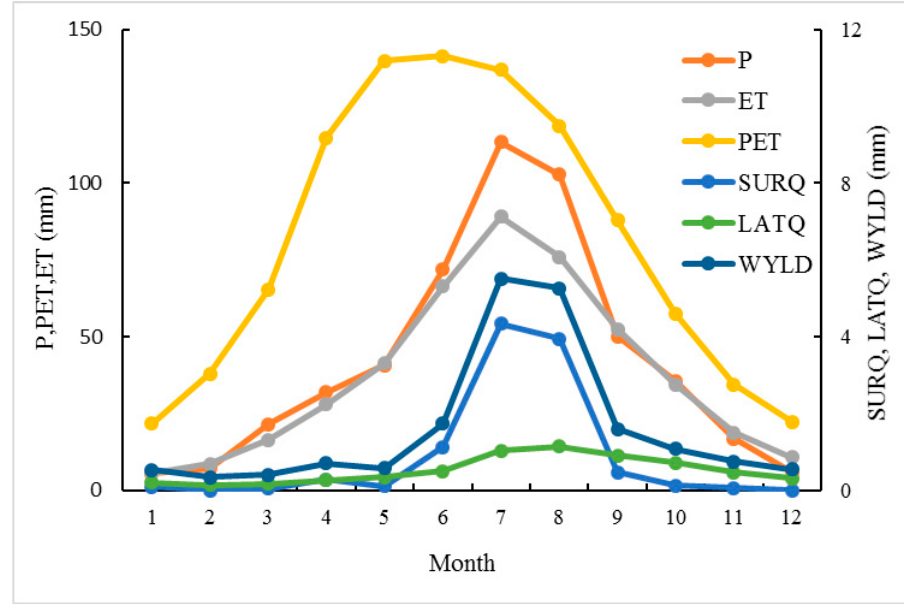
Figure 6. Monthly mean water balance components from 1986 to 1999. (P: precipitation, ET: actual evapotranspiration, PET: potential evapotranspiration, SURQ: surface runoff, LATQ: lateral flow, WYLD: water yield = SURQ + LATQ + GWQ − transmission losses (TLOSS) − pond abstractions.).